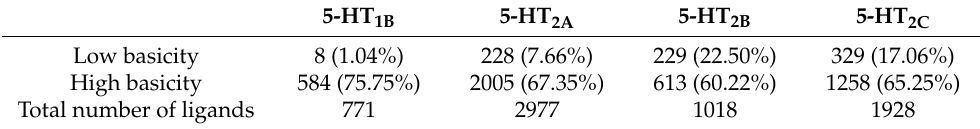
Table 2. Comparison of the number of records with low (pK a < 6) and high (pK a > 8) basicity for the considered targets. In brackets, the fraction of basic ligands among all active compounds is provided.